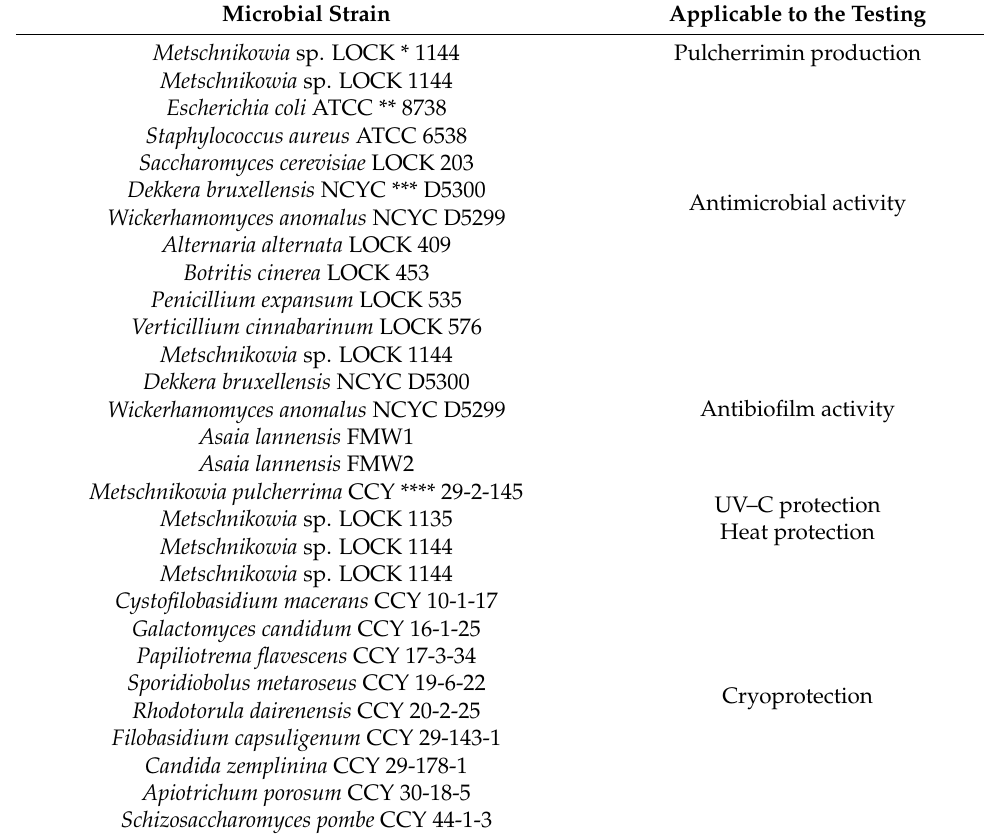
Table 2. Microbial strains used in the